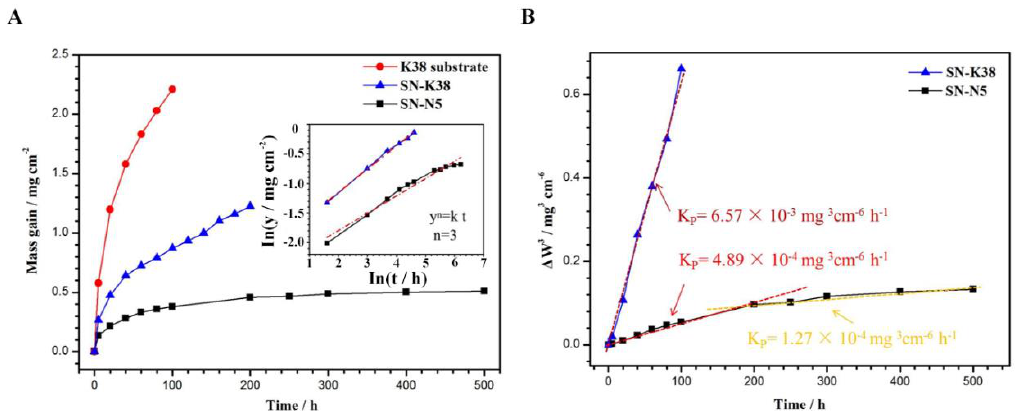
Figure 2. ( A ) Oxidation kinetics of superalloy substrate K38 and nanocrystalline coatings; ( B ) Function relationship between log( y ) and log( t ) was also plotted in ( A ).